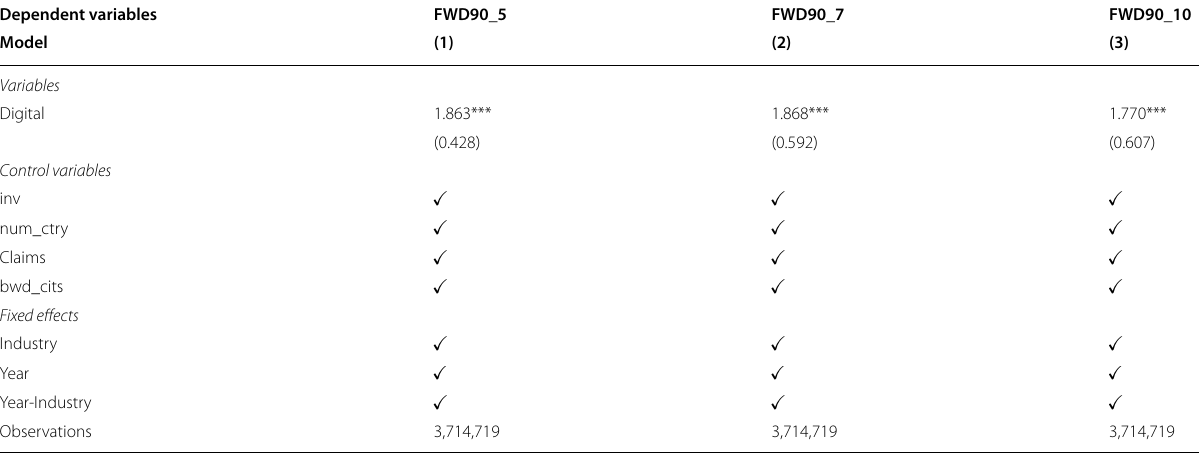
Table 8 Technological improvement rates and breakthrough innovations: different time spans of forward